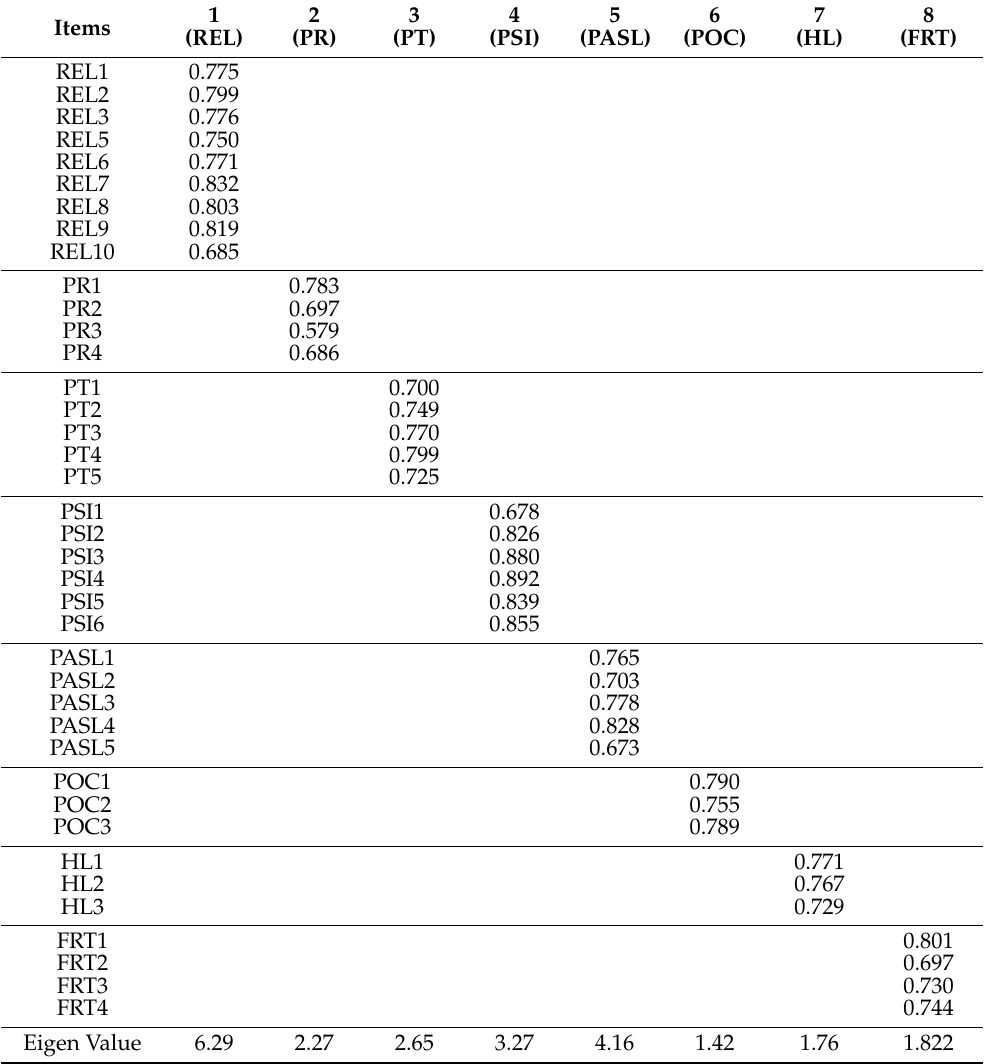
Table A1. Exploratory factor analysis results: factor loadings of all the variable